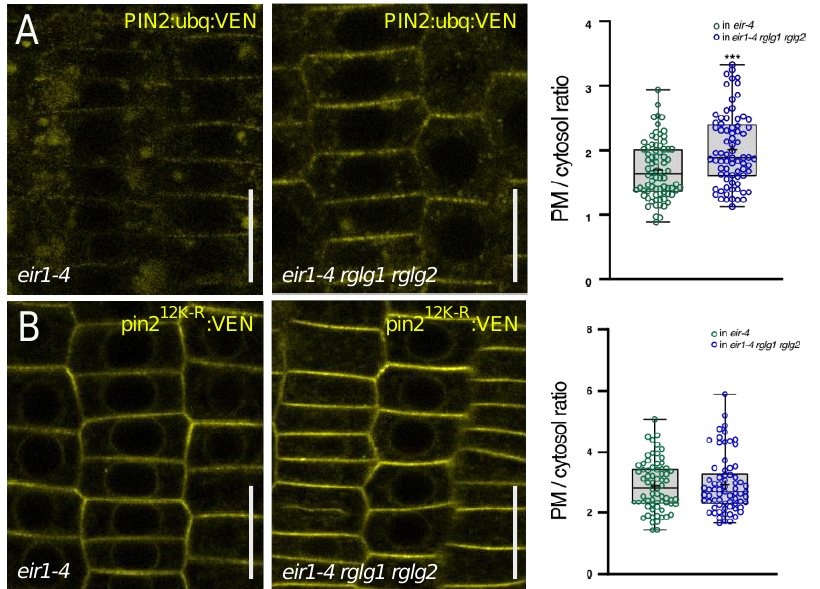
Figure 6. ( A ) PIN2:ubq:VEN (yellow) in eir1-4 (left panel) or eir1-4 rglg1 rglg2 (middle panel) root meristem epidermis cells at 5 days after germination. Right panel: Quantification of PIN2:ubq:VEN signals at the plasma membrane (PM) and in the cytosol in eir1-4 or eir1-4 rglg1 rglg2 root meristem epidermis cells ( n = 70–80). ( B ) pin2 12K-R :VEN (yellow) in eir1-4 (left panel) or eir1-4 rglg1 rglg2 (middle panel) root meristem epidermis cells at 5 days after germination. Right panel: Quantification of pin2 12K-R :VEN signals at the plasma membrane (PM) and in the cytosol in eir1-4 or eir1-4 rglg1 rglg2 root meristem epidermis cells ( n = 70–80). Circles represent single data points; boxes: first and third quartiles; center line: median; ‘+’: mean value. Two-tailed t -test was employed to determine statistical significance; ***: p < 0.001. Size bars: 10 µ